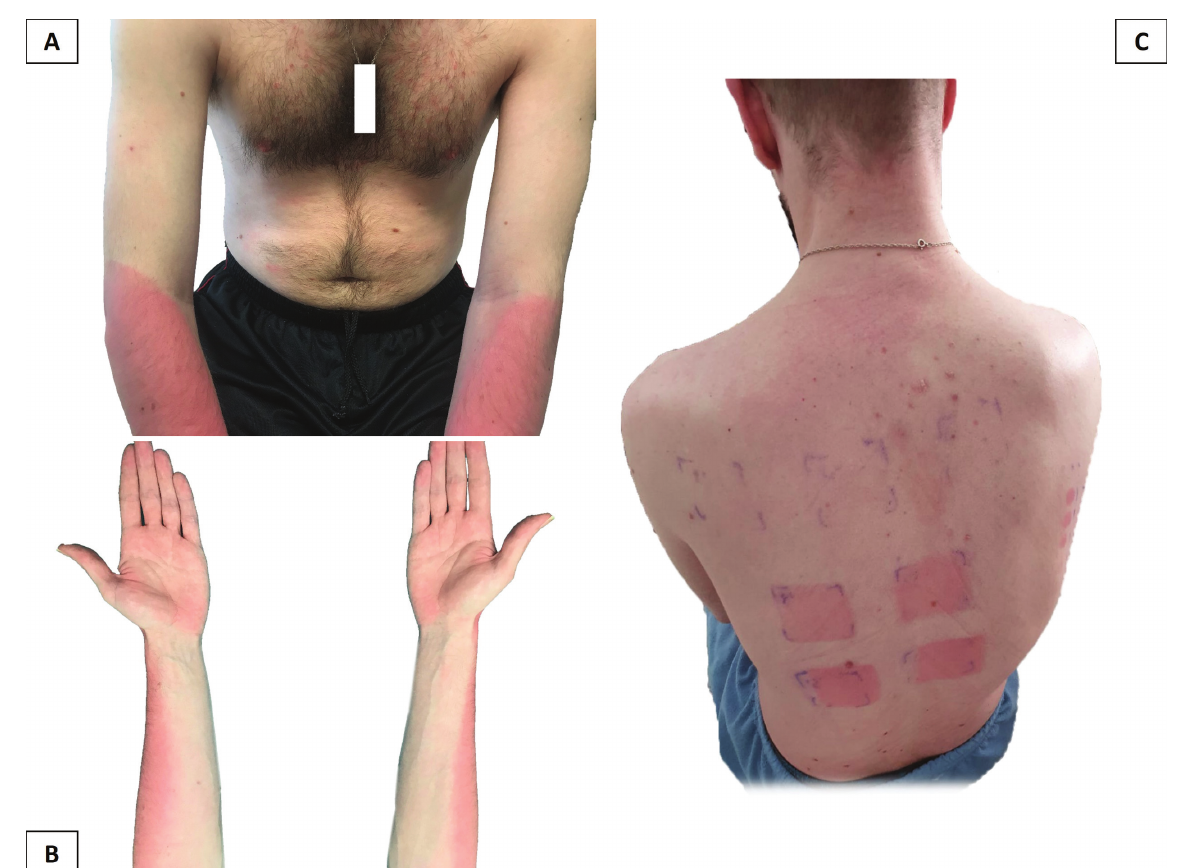
Fig. 1 ( A, B ) Appearance of cutaneous erythema in photoexposed areas. ( C ) Phototest revealing erythema and edema.